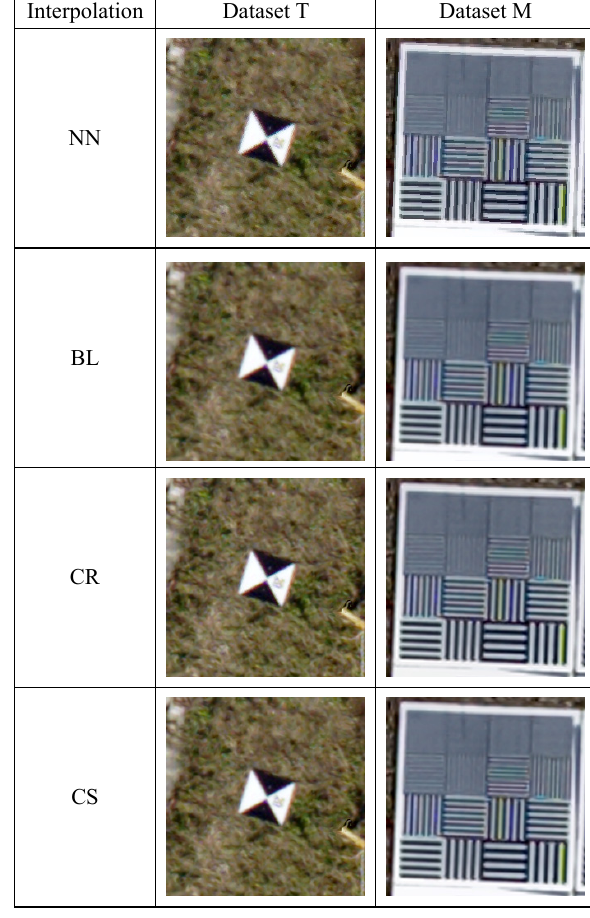
Figure 8. Results of